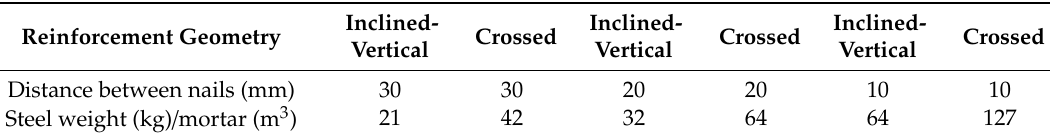
Table 1. Reinforcement configuration with nails and steel reinforcement density (in kg per cubic meter of cementitious material. Reinforcement